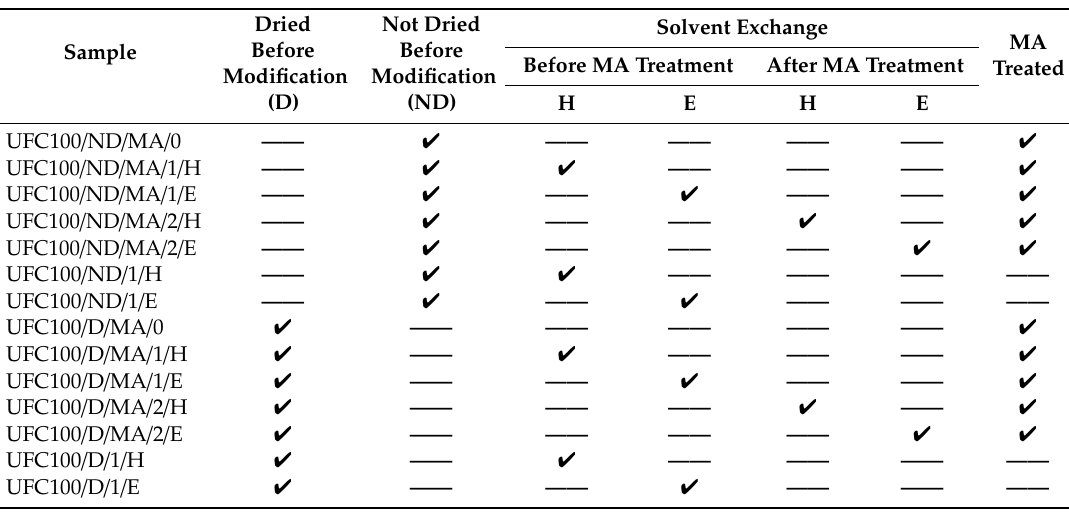
Table 2. Summary of all performed cellulose fibers